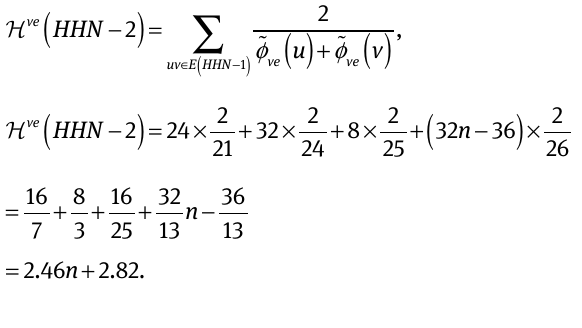
Figure 3: Graphical comparison of